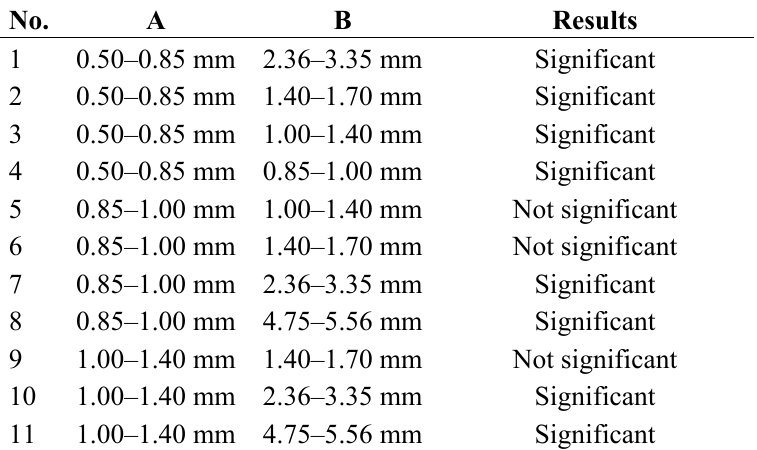
Table 5. Scheffé’s post-hoc comparisons of P removed using different slag particle sizes (A vs.